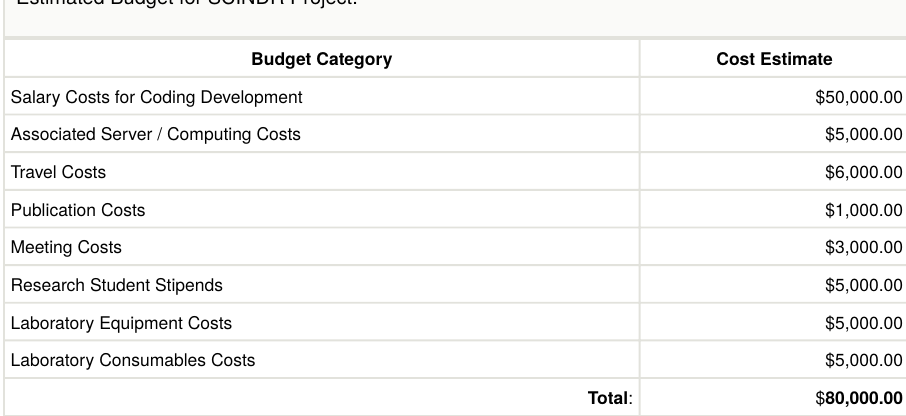
Estimated Budget for SCINDR